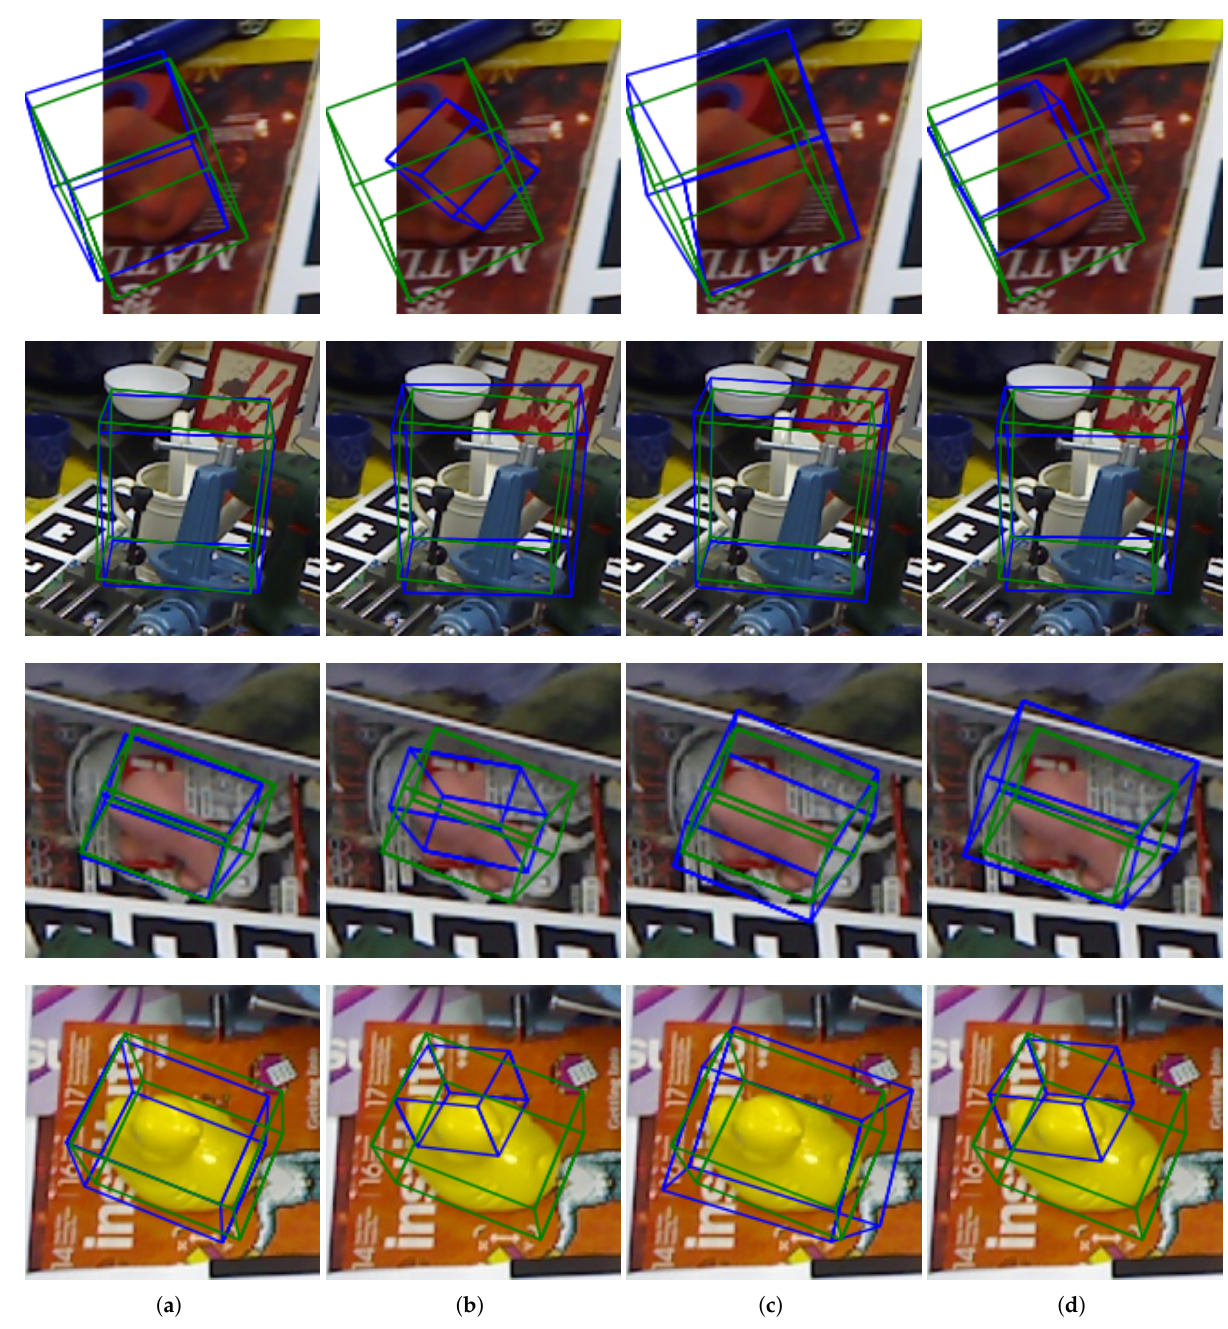
Figure 6. Visualized results of different algorithm configurations. ( a ): full algorithm; ( b ): without the optimization module; ( c ): without translation model; ( d ): without optimization module and translation